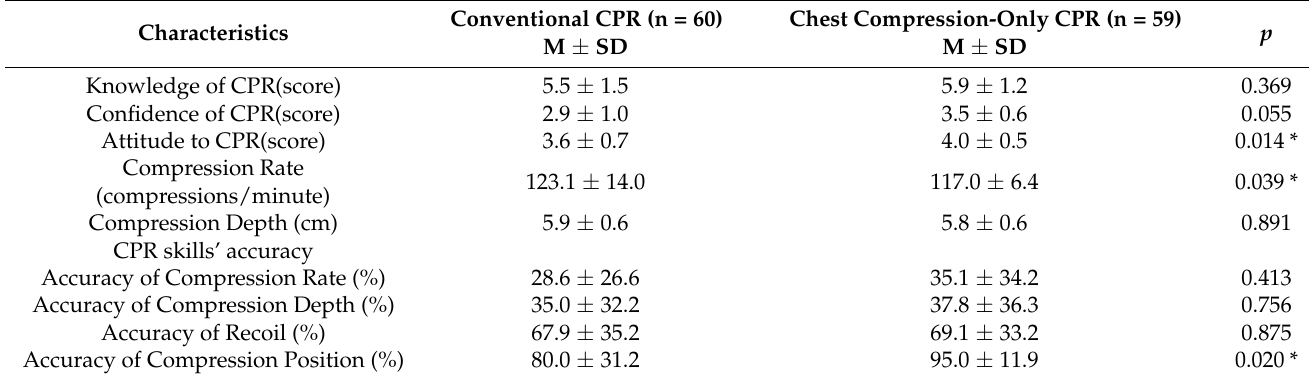
Table 3. Knowledge, confidence, attitude, and CPR skills at 3 months after CPR training.